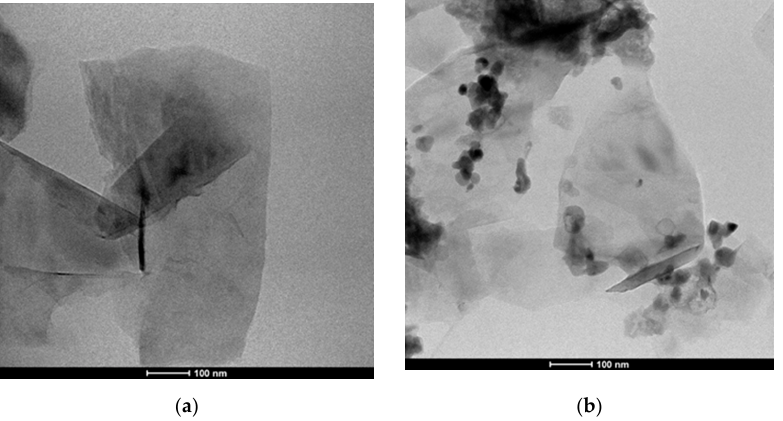
Figure 11. TEM photographs: ( a ) pristine graphene flakes with lateral size of several hundred nm folded and casually overlapped; ( b ) Gr-ZnO/NP nanocomposites. The nanoparticles are mainly amassed along the edges of the flakes.